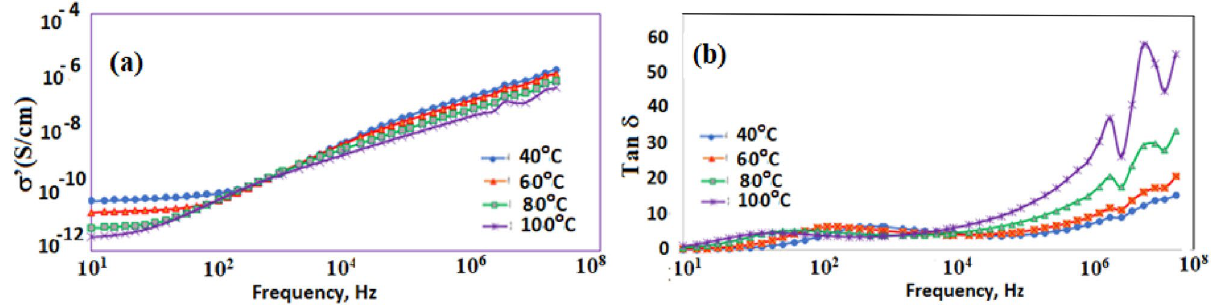
Figure 8. ( a ) Conductivity (σ ′ ) vs frequency- and ( b ) Dissipation factor (tan δ) vs frequency for polymer 2 at temperature range 40–100 °C.